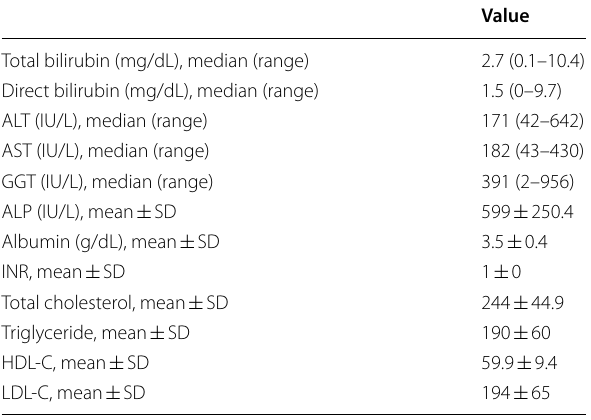
Table 2 Liver function tests and lipid profile of the studied